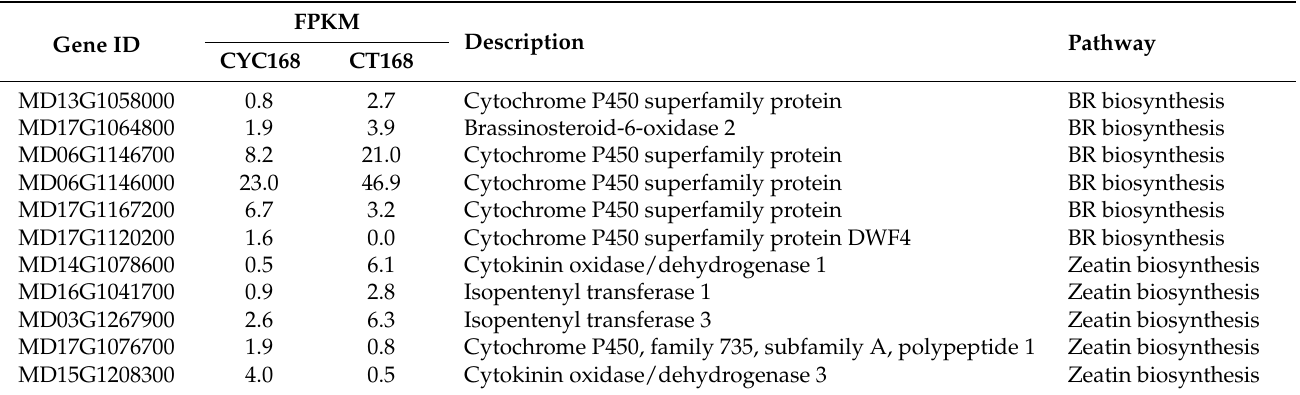
Table 2. The differentially expressed genes in the brassinosteroid and zeatin biosynthesis pathways at 168 h after cyclanilide